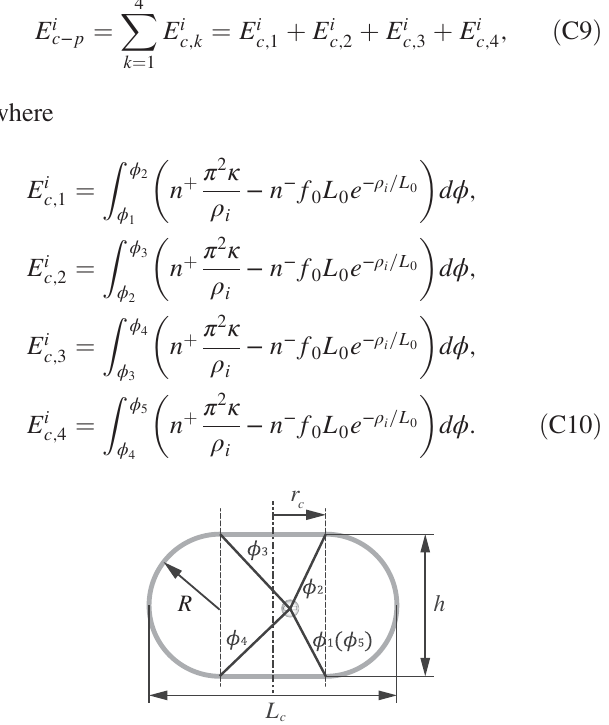
FIG. 13. Cell under four-wall confinement regarded as a stadium shape with two semicircular ends. For the sake of calculation, the cell is divided into four parts.